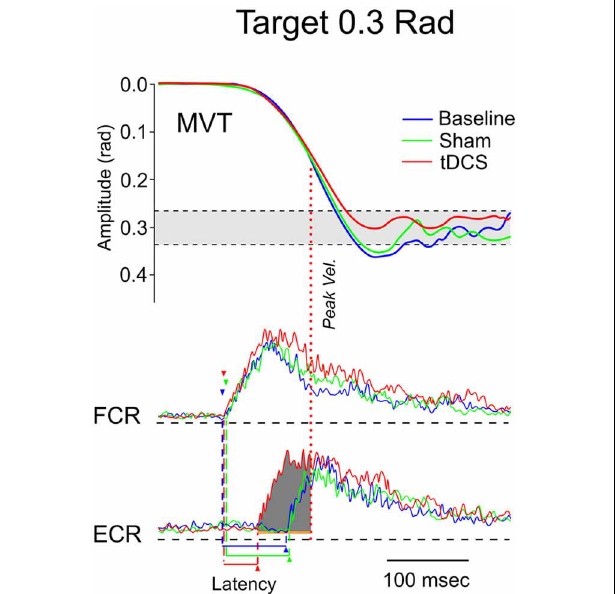
FIGURE 8 | Fast goal-directed wrist flexion movements in patient 1. Target located at 0.3 rad from the start position. Top part : mean movement (MVT; averages of sets of 10 movements) in the 3 experimental conditions (blue line: basal condition, green line: sham, red line: post-tCCDCS); gray area corresponds to the mean ± 2.5 SD of position values obtained in a control group. Middle and bottom part : FCR and ECR correspond to averages (for the 10 movements) of full-wave rectified surface EMG activities of the flexor carpi radialis muscle (agonist muscle) and extensor carpi radialis muscle (antagonist muscle), respectively (blue lines: basal condition, green lines: sham, red lines: post-tCCDCS). Arrowheads indicate the onset of EMG activities (blue: baseline; green: post-sham; red: post-tCCDCS). Note that the burst of antagonist EMG activity starts earlier after tCCDCS, demonstrating an effect of tCCDCS on the timing of antagonist EMG activity. The dark gray area below the ECR trace corresponds to the portion of EMG activity occurring before the peak velocity (illustrated by a red dotted line, whereas the peak velocity for the baseline and post-sham condition occurred before the onset latency of the antagonist EMG activity), and thus having an efficient braking action to avoid the overshoot of the target.